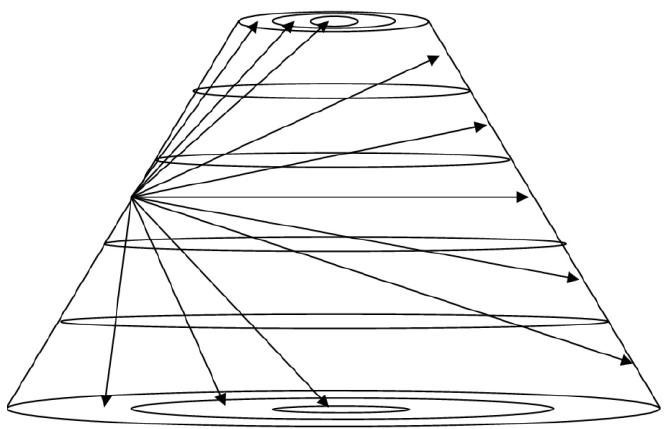
Figure 4. Different view factors calculations from a lateral